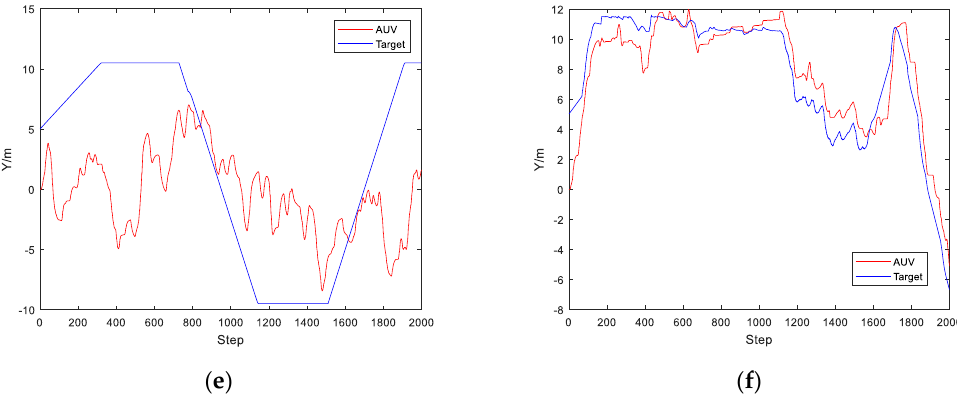
Figure 11. The coordinate change curves during the process of AUV tracking the target using PPO, GAIL, and MAG, respectively, training 20,000 times in scene 2: ( a – c ) the X-coordinate change; and ( d – f ) the Y-coordinate change.